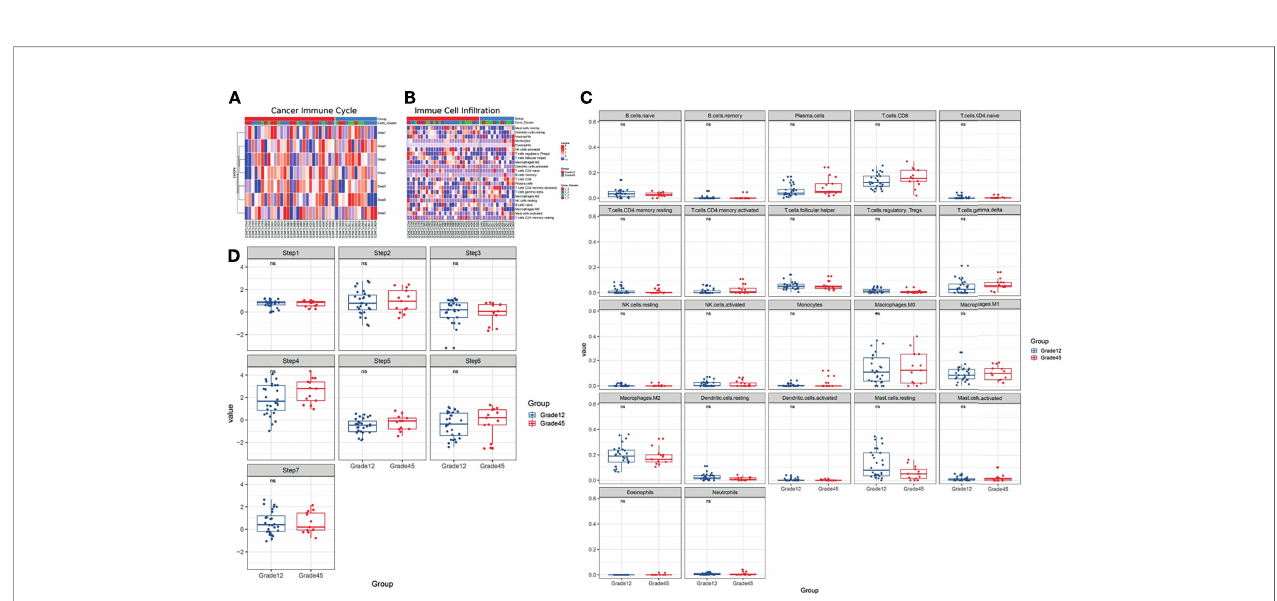
FIGURE 3 | (A, B) Using Cancer Immune Cycle and Immune Cell In fi ltration to evaluate the tumor immune microenvironment. (C) CIBERSORT method is used to analyze the proportion of 22 immune cells in fi ltration in tumor samples. (D) The ssGESA method is used to calculate the cancer immune circle. ns, no signi fi cance.